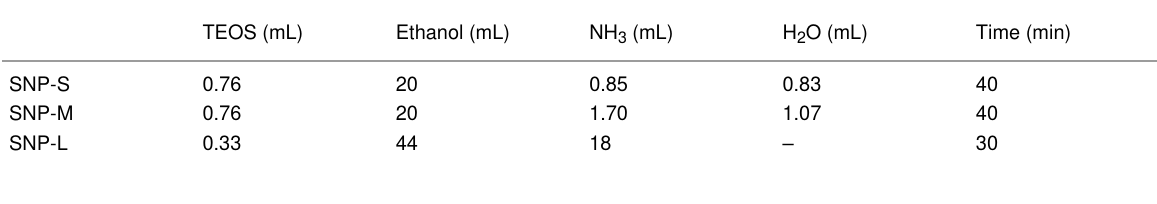
Table 2: Synthesis parameters for